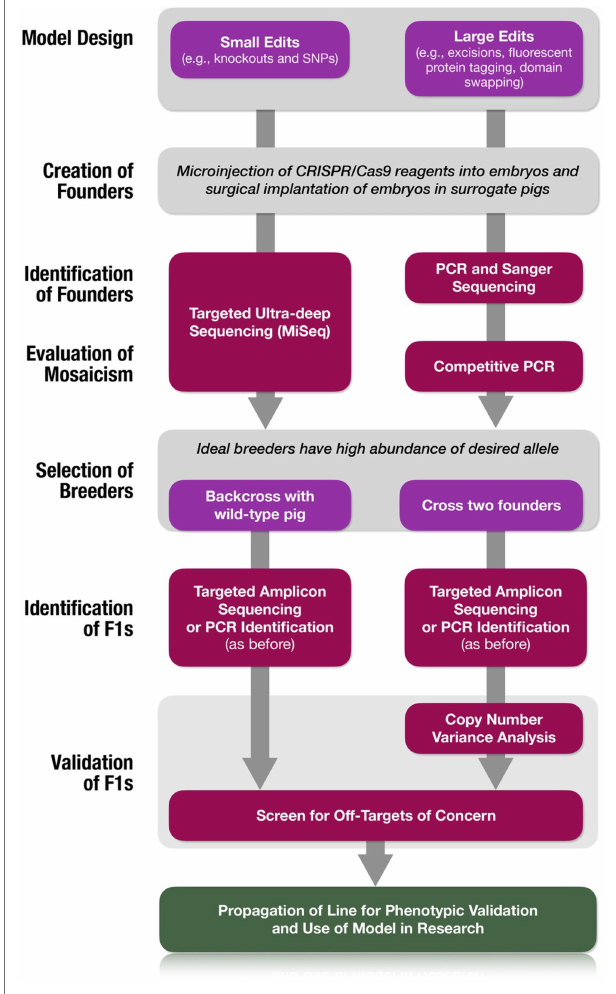
FIGURE 7 | Simplified workflow for creation of validated swine models. Decision trees are provided for the type of edit being introduced as well as the strategy for the utilization of founders for the expansion of the